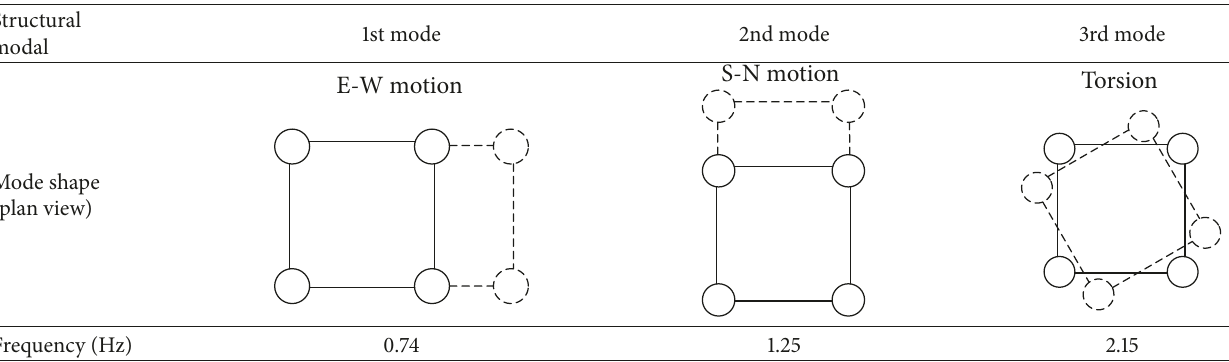
Table 4: Modal parameters of